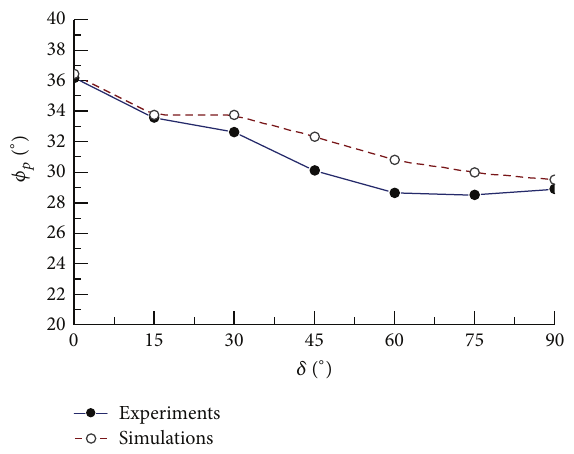
Figure 5: Comparison of peak friction angle 𝜙 𝑝 between experi- ments and simulations.